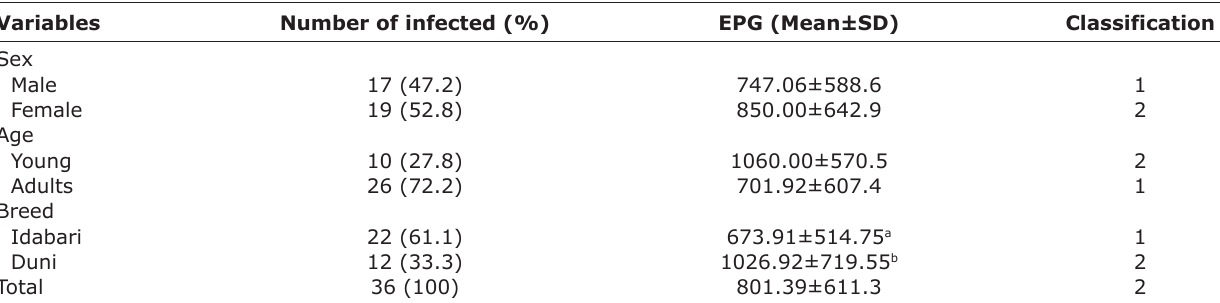
Table-2: Nematode EPG of feces of infected slaughtered donkeys. Variables